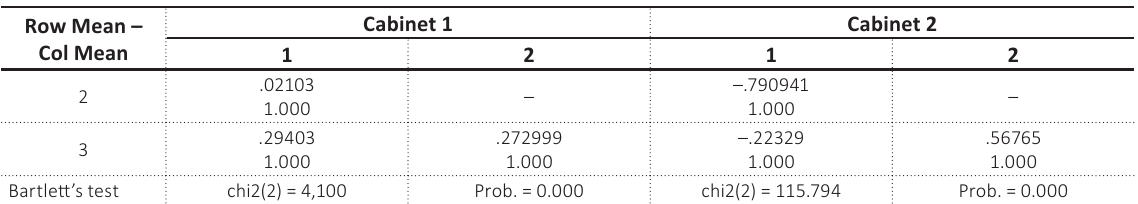
Source: Processed dataset by the